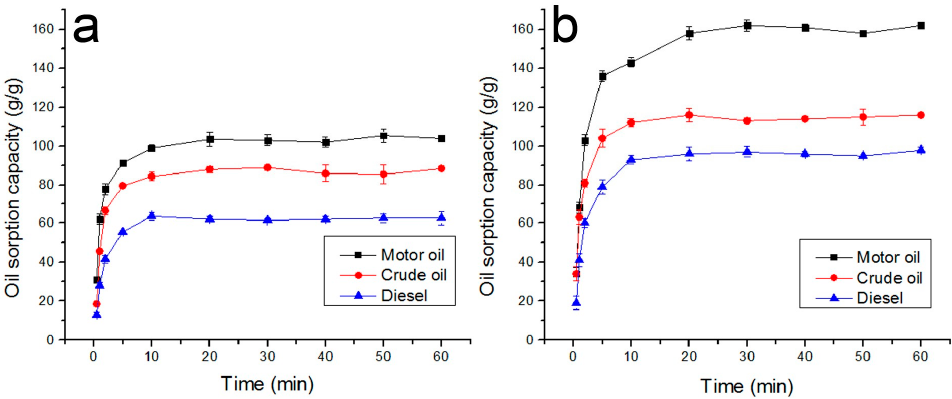
Figure 10. Adsorption kinetic curve (( a ) raw PLA fiber; ( b ) (8% H203)/PLA fiber).